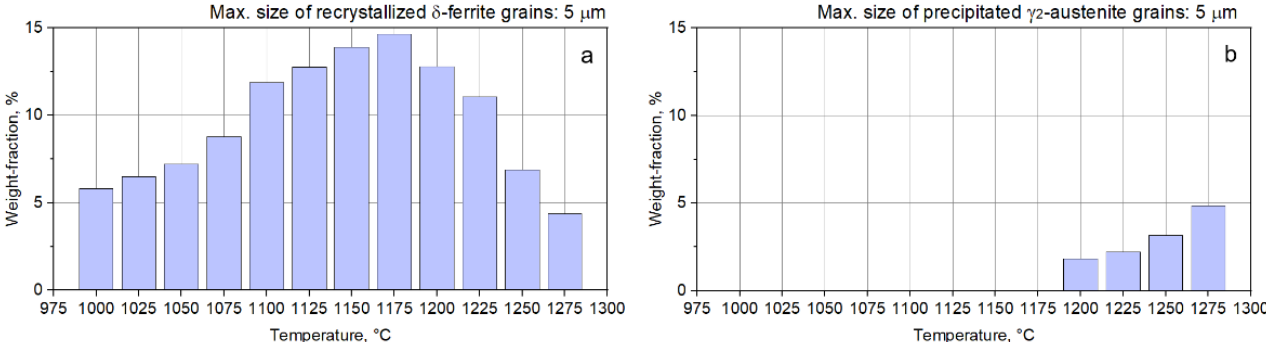
Figure 8. Typical random-colorized γ-phase grain size distribution maps in hot-deformed UNS S32750 SDSS alloy (from 1200 °C to 1275 °C).